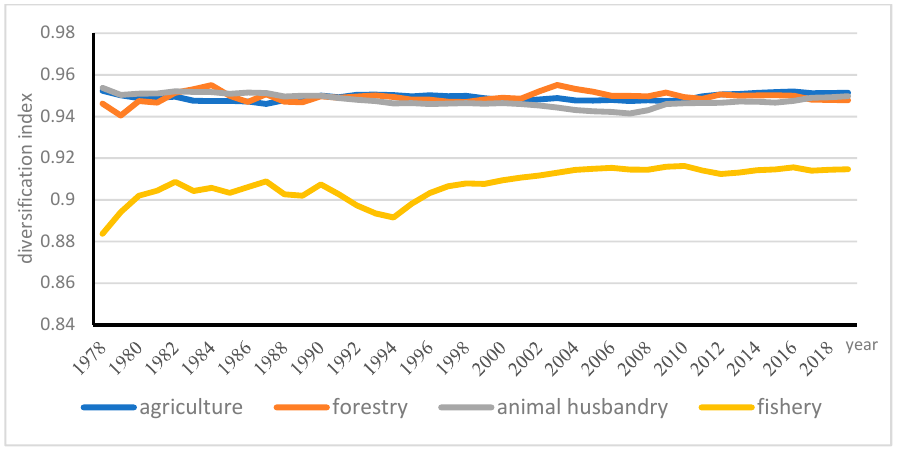
Figure 14. Diversification indices of four subsectors in China.